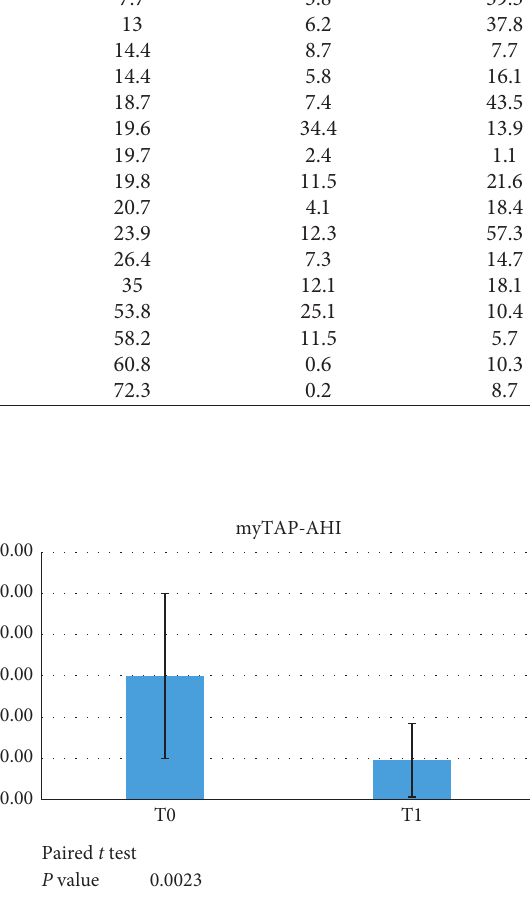
Figure 2: Paired t -test data showed a significant difference between ODI scores at T0 versus T1 ( p < 0 . 05) when evaluating the use of the myTAP ™